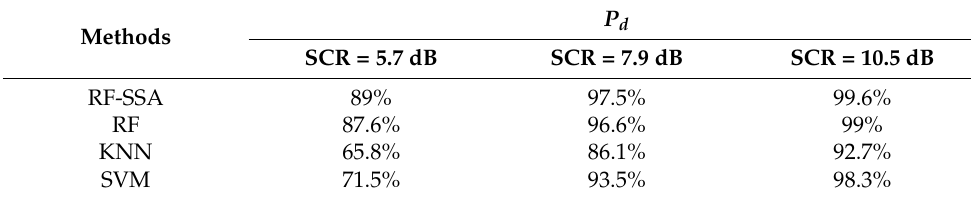
Table 7. Comparisons of AUC.